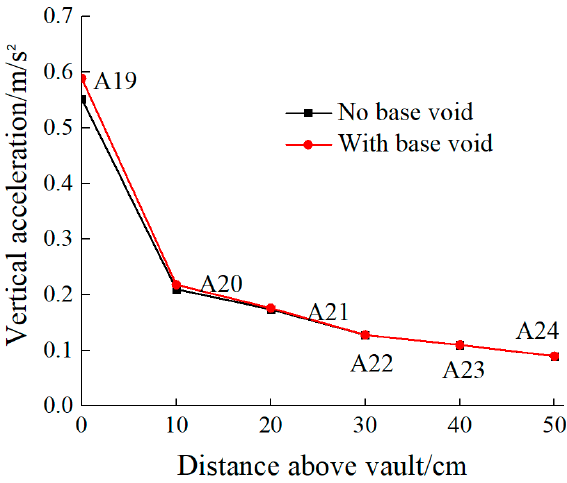
Figure 19. Peak acceleration of soil measurement points above the tunnel